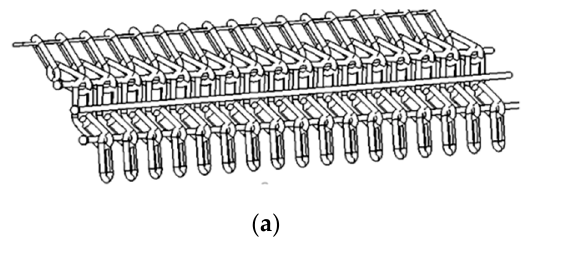
Figure 2. “Chain separation curtain” and soil retaining board. ( a ) Schematic diagram of “Chain separation curtain”. ( b ) Schematic diagram of soil retaining board.